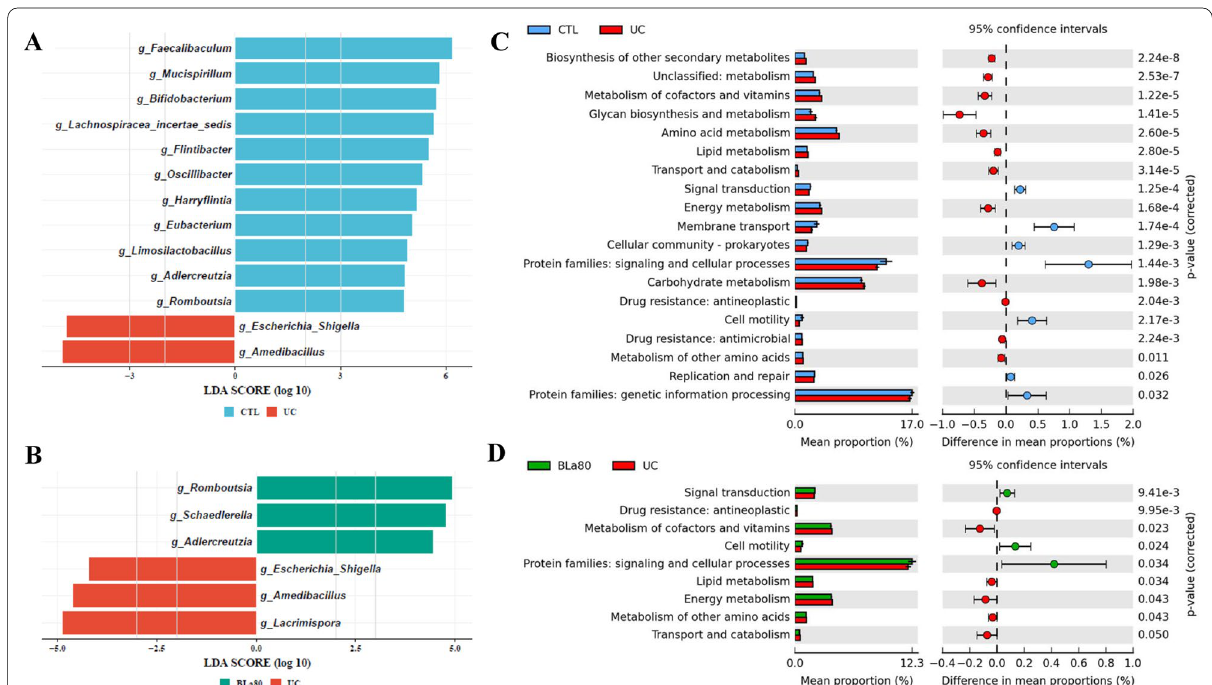
Fig. 6 Metagenomic biomarker discovery (LEfSe) and PICRUSt functional analyses. Differential enriched bacterial taxa at the genus level in gut microbiota of mice after DSS treatment ( A CTL vs UC) and after BLa80 intervention ( B UC vs BLa80). Extended error bar plots representing microbial pathways predicted to be differentially enriched after DSS treatment ( C CTL vs UC) and microbial pathways predicted to be differentially enriched after BLa80 intervention ( D UC vs BLa80). For LEfSe analysis, the threshold LDA score was